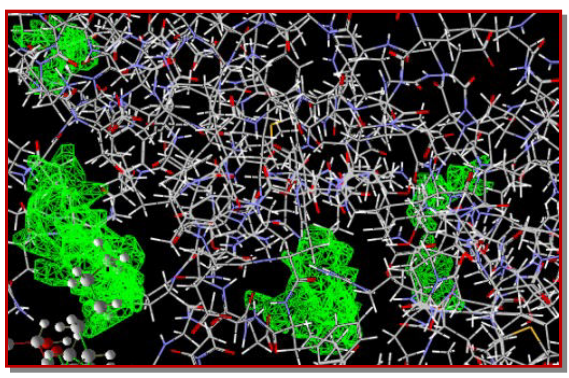
Figure 1: Predicted cavities of arabinosyl transferase